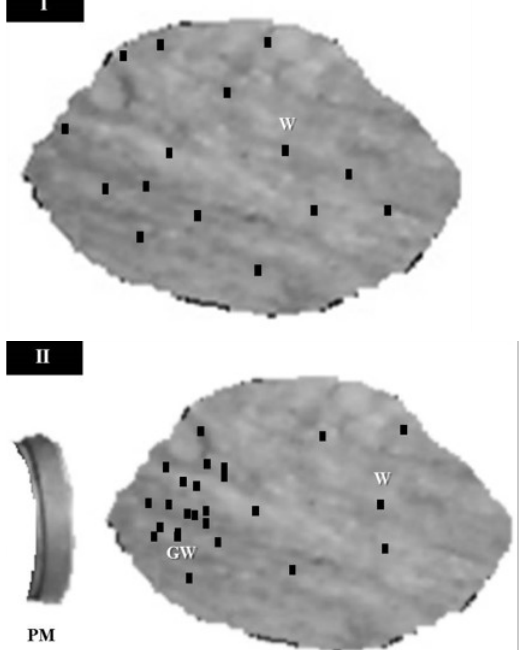
Fig 3 . Representation of the grouping behavior of Polybia paulista workers (GW) on the nest surface during session A (I), before the application of the altered magnetic field with the permanent magnet (PM); and during session B (II), with the permanent magnet in place. GW – Grouping of Wasps; W- Wasp.